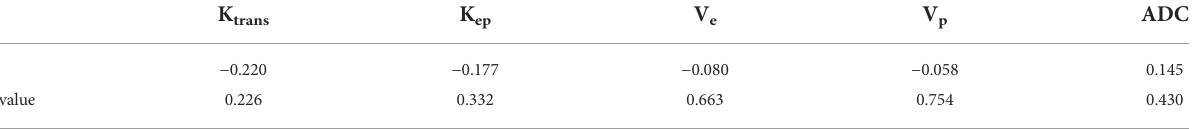
TABLE 5 Spearman correlations between imaging parameters and Gleason stage.